Question: Briefly state, in one sentence, what is plotted here.
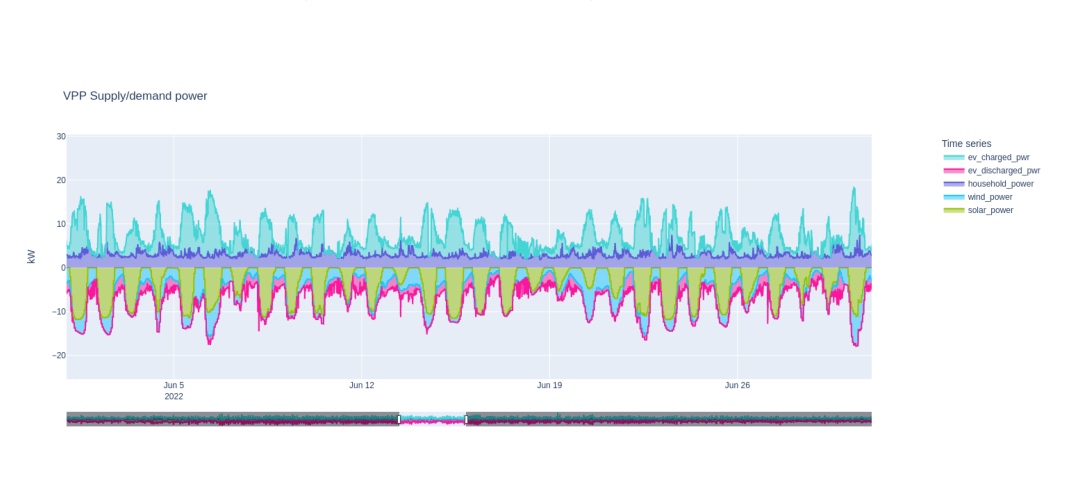
Answer: 8: EVs energy at departure histograms, algorithms comparison.